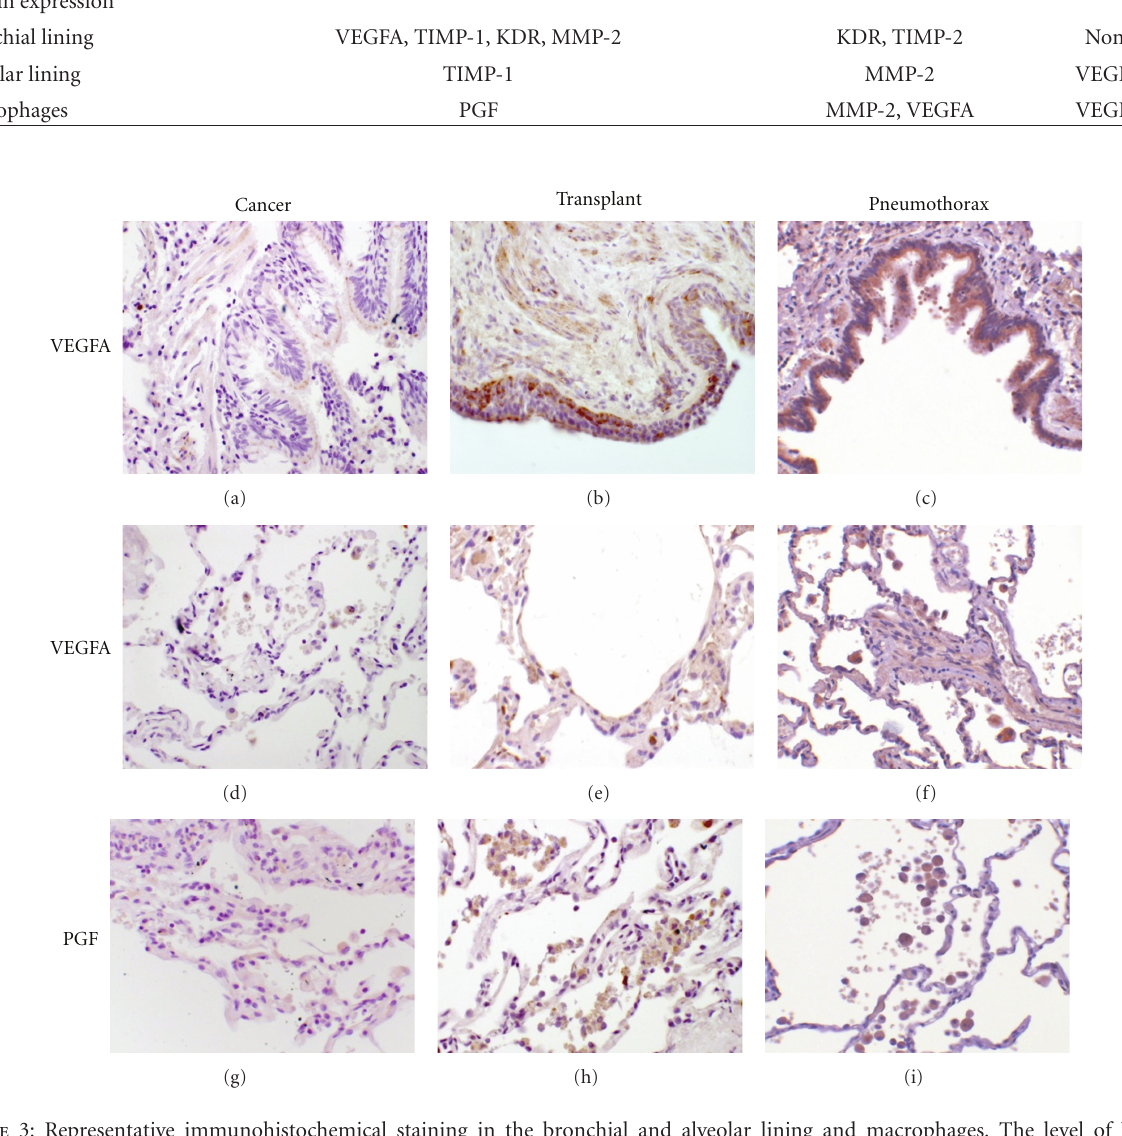
Figure 3: Representative immunohistochemical staining in the bronchial and alveolar lining and macrophages. The level of VEGFA expression was diminished in the bronchial lining of cancer resection (a) compared to transplant biopsy (b) and pneumothorax (c). The alveolar lining shows elevated levels of VEGFA in pneumothorax (f) compared to cancer resection (d) and transplant biopsy (e). The level of PGF expression was diminished in macrophage infiltrate in lung cancer (g) compared to transplant biopsy (h) and pneumothorax (i). Magnification